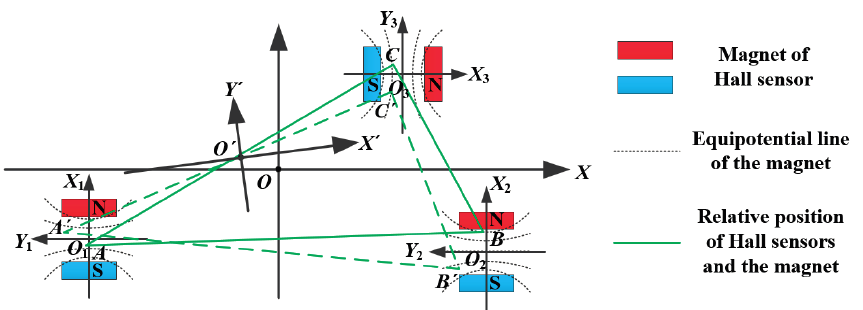
Figure 4. Measurement model of Hall sensors with three